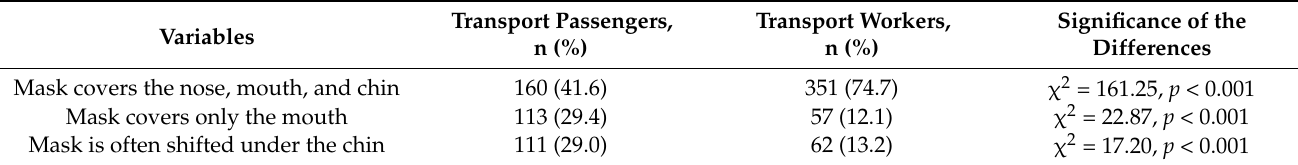
Table 3. Methods of face mask